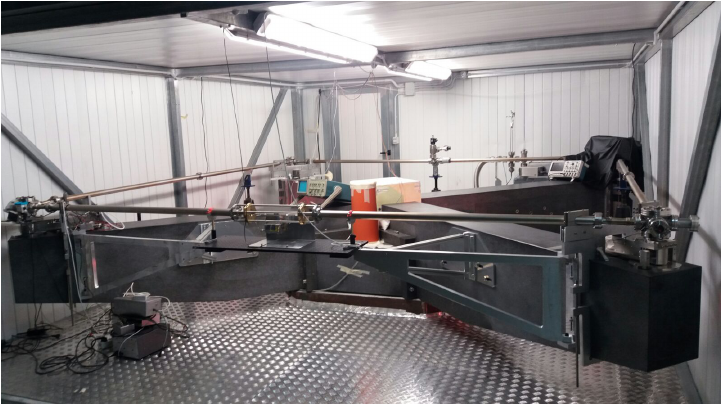
Figure 1. The Gingerino active ring laser gyroscope inside the Gran Sasso national laboratory of the